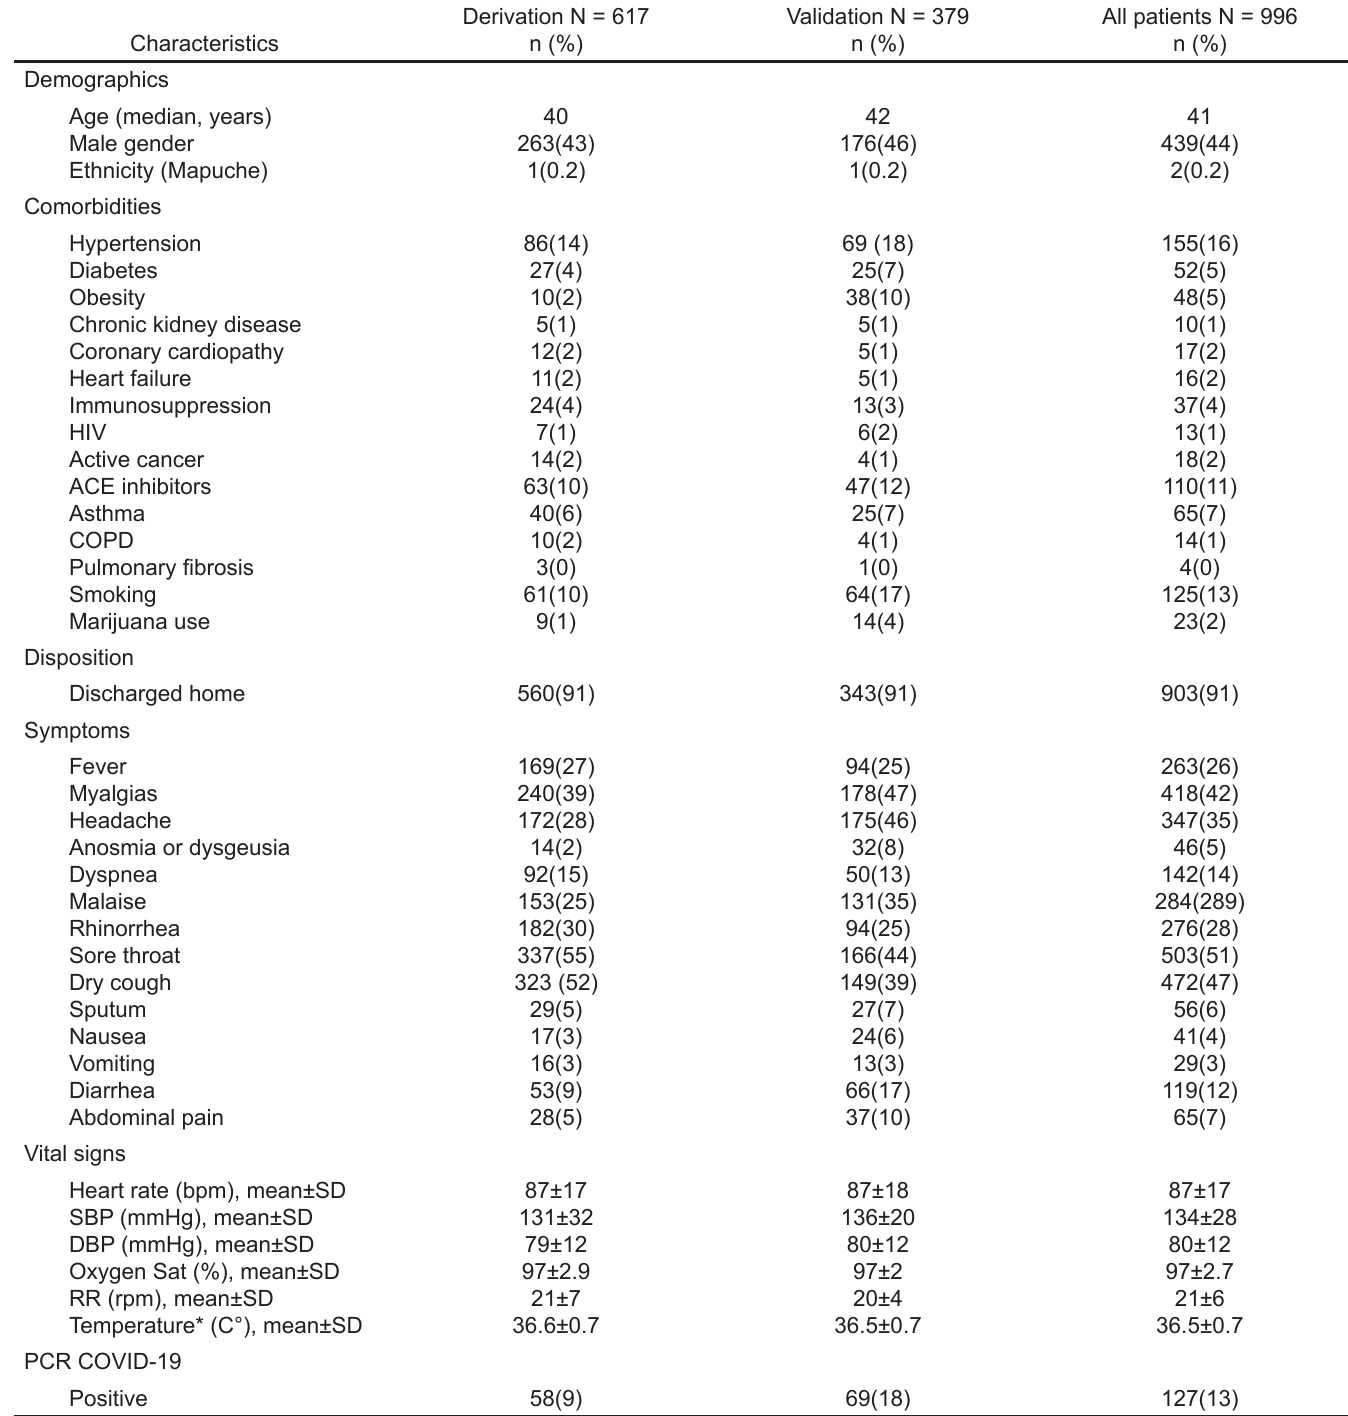
Table 1. Characteristics of derivation and validation